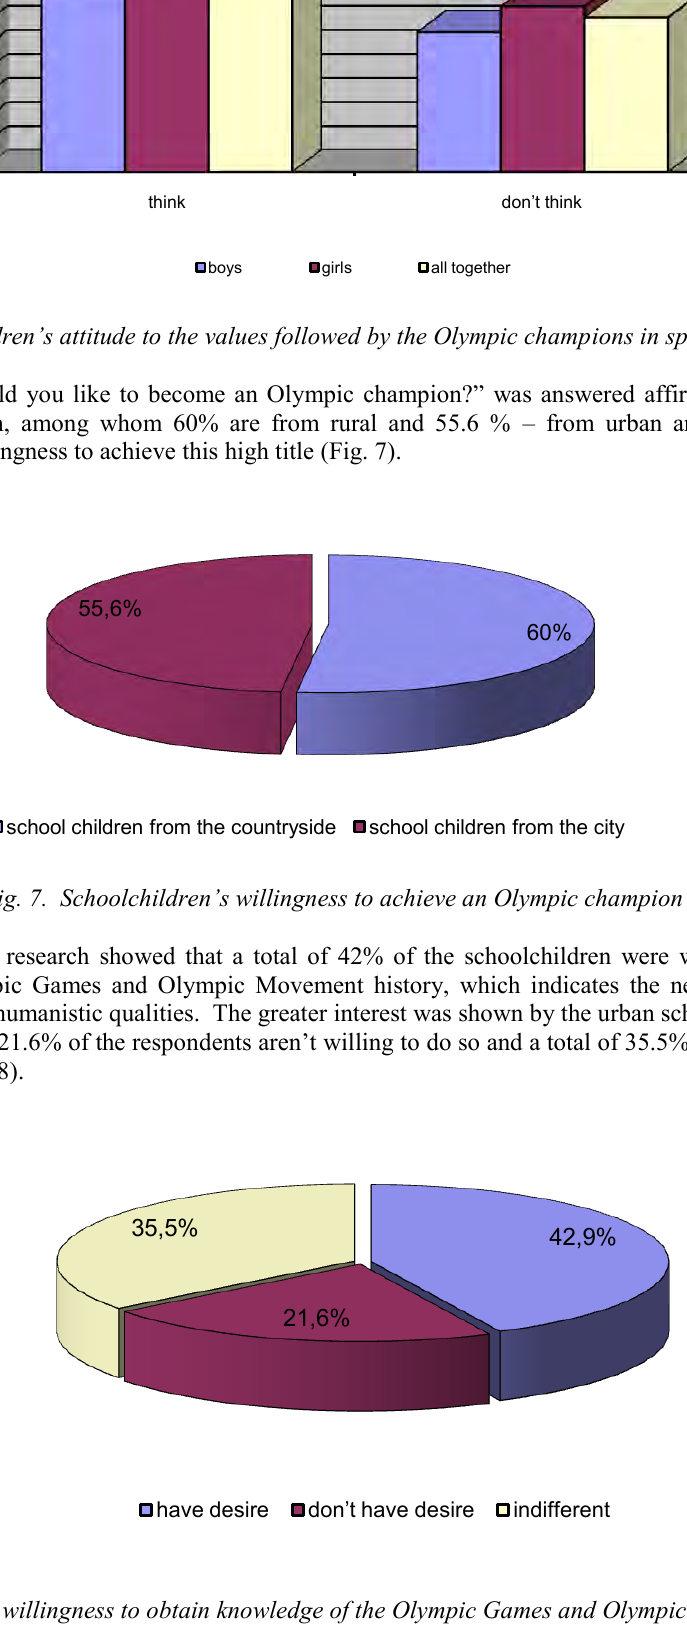
Fig. 8. Schoolchildren’s willingness to obtain knowledge of the Olympic Games and Olympic Movement